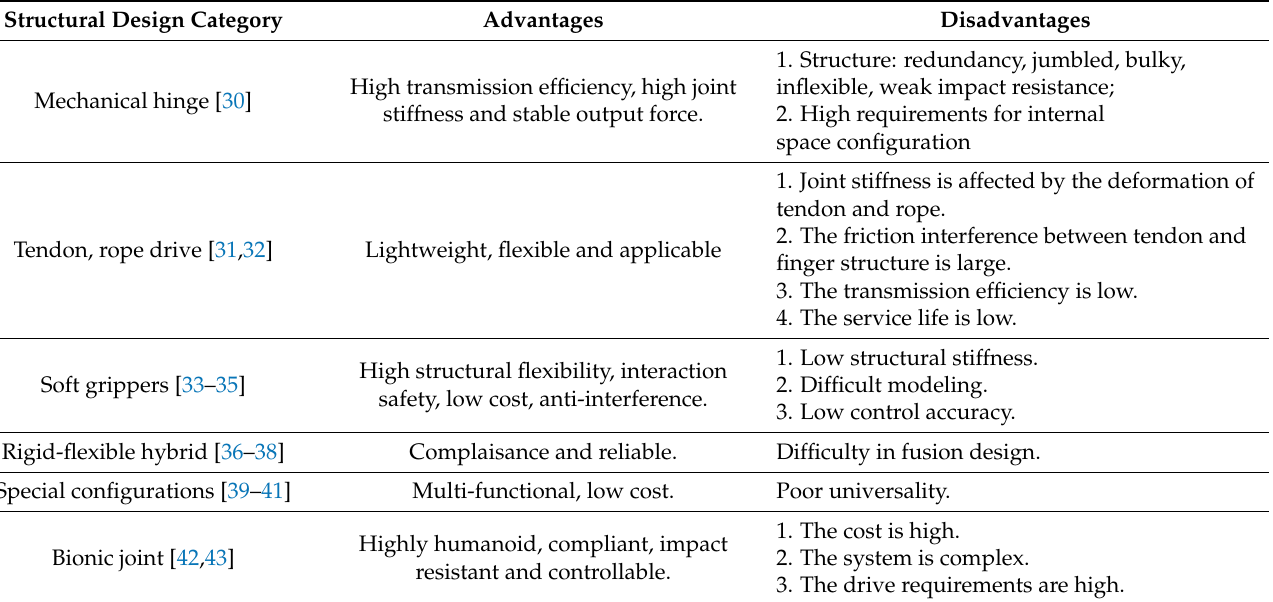
Table 1. The various gripper structural